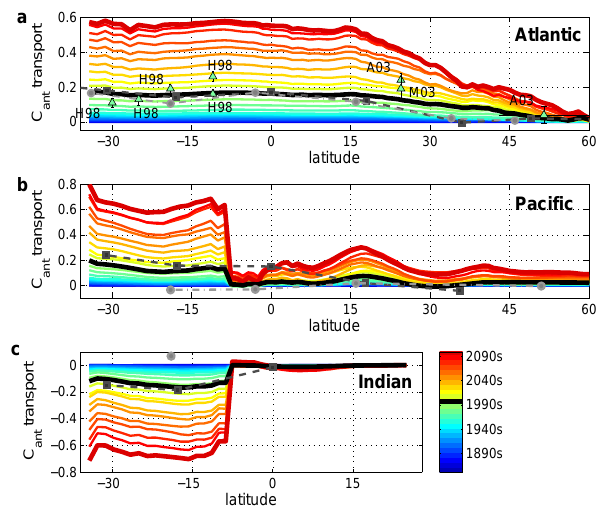
Fig. 3. Simulated meridional transport strength of C ant in the (a) At- lantic, (b) Pacific, and (c) Indian Oceans basin for the 1850–2099 period, plotted as a function of latitude. Each lines represents decadal-averaged northward fluxes. Units are in (PgCyr − 1 ). All observational based estimates represent the present day (1990s– 2000s) periods. H98: Holfort et al. (1998), A03: ´Alvarez et al. (2003), M03: Macdonald et al. (2003), dark grey squares are from inversion study (Mikaloff Fletcher et al., 2006; Gruber et al., 2009), and light grey circles are from mean reconstruction estimates using the Ensemble Kalman Filter (Gerber et al.,